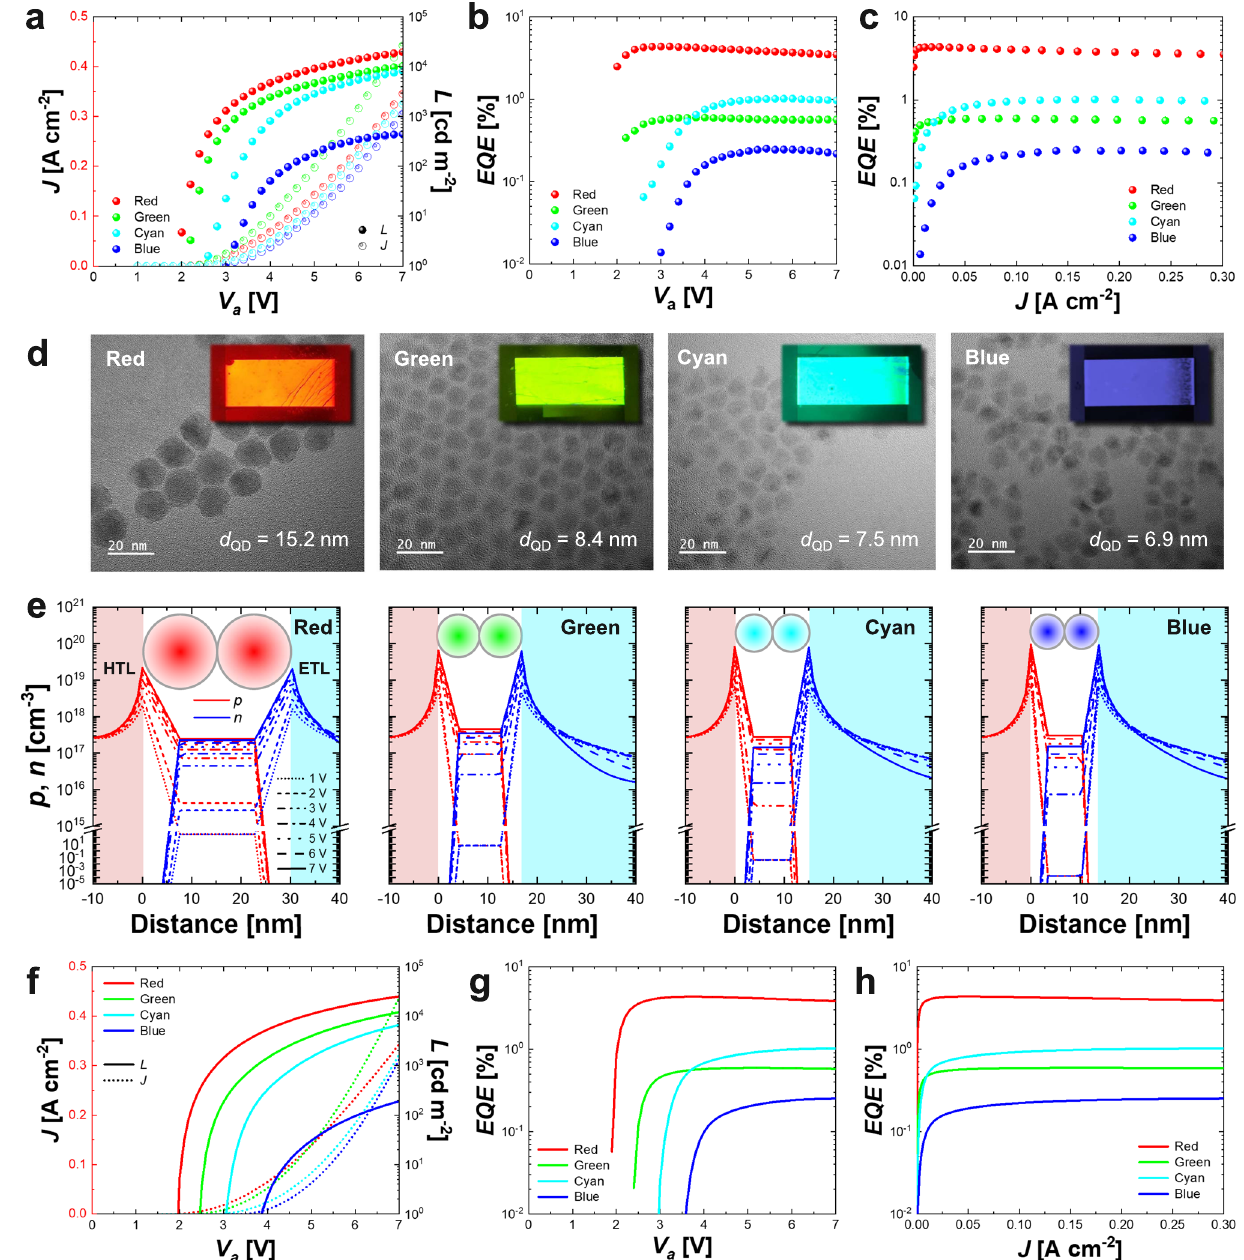
Fig. 3 Electro-optical characteristics of monochromatic QD-LEDs obtained from the experiments and the charge transport simulation. a Voltage ( V a ) dependencies of current density ( J ) and luminance ( L ) of fabricated red, green, cyan, and blue monochromatic QD-LED devices. b , c EQE curves of the fabricated monochromatic devices for the voltage ( b ) and the current density ( c ). d TEM images for the particle sizes of red, green, cyan, and blue QDs used for the device fabrication and charge transport simulation. d QD is the average diameter of the QD nanoparticles. Insets are the snapshots of EL-driven monochromatic red, green, cyan, and blue QD-LED devices fabricated by the transfer printing technique. The size of the fabricated device is 3.0 × 1.5 mm 2 . e Simulated hole and electron density distributions around the QD layers for red, green, cyan, and blue QD-LED devices for the applied voltages from 1 V to 7 V with 1 V step. f Simulated voltage dependencies of current density and luminance of QD-LED devices. g , h Simulated EQE curves for the voltage ( g ) and the current density ( h ). The simulation parameters are extracted with the charge transport model by emulating the experimental EQE-current density curves of the fabricated monochromatic printing technique with an emission size of 3.0 × 1.5 mm 2 . For the These QD parameters extracted from the experiments and particle sizes and the EQE-current density curves of each QD- simulation are listed in Supplementary Table 3. LEDs given in Fig. 3c, the material-level parameters such as Figure 3e shows the simulated hole and electron density the Shockley-Read-Hall (SRH) recombination lifetime τ and the distributions near the QD layers of the red, green, cyan, and blue Auger capture probability C of individual QD-LED device were QD-LED devices for different voltages. The theoretical energy obtained by matching the simulated EQE-current density curves bandgaps of the red (616 nm), green (559 nm), cyan (502 nm), with the experimental EQE-current density curves in Fig. 3c. and blue (450 nm) QDs used in the simulation are calculated to